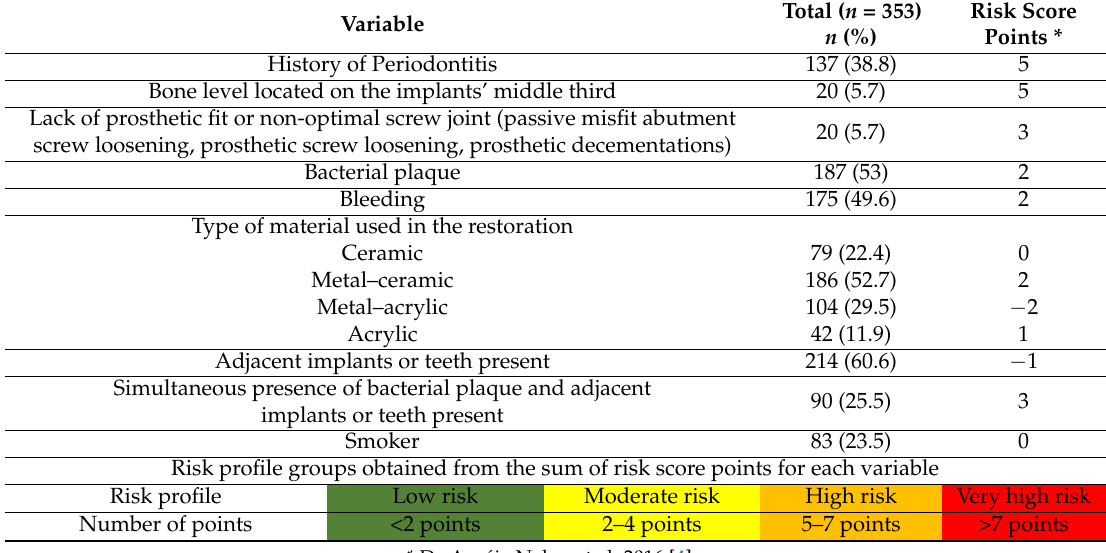
Table 1. Baseline patient characteristics, risk score points and illustration of the relationship between the points system and the risk profile